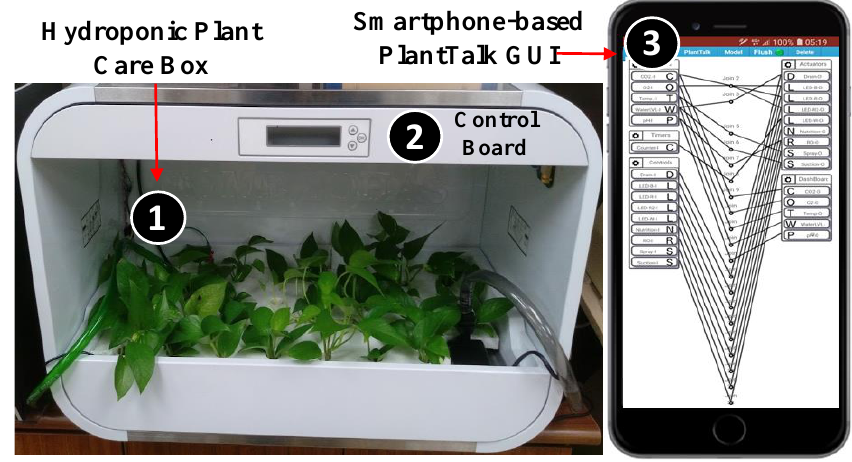
Figure 1. The hydroponic plant box and the PlantTalk GUI.